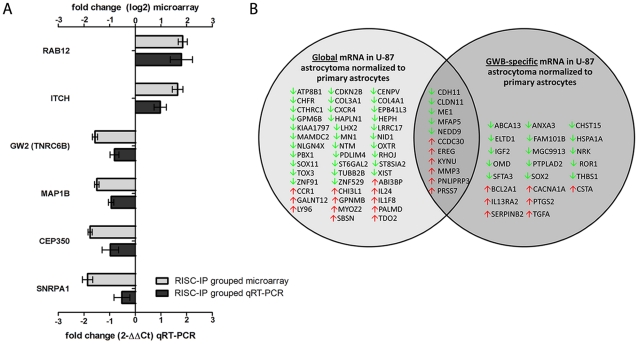
(A) MRNA microarray validation with qRT-PCR analysis in grouped RISC-IP U-87 astrocytoma and primary astrocytes samples. Grouped RISC-IP data were compared to the grouped global mRNA from U-87 astrocytoma and primary astrocytes samples. Eight mRNAs were selected from the grouped mRNA microarray dataset and examined by qRT-PCR. Fold change from the mRNA microarray are given by log2 values (left y-axis, light grey bars). Fold change from the qRT-PCR was determined using the 2-ΔΔCt method and all mRNA expression values were normalized to the beta-actin endogenous control (right y-axis, dark grey bars). Error bars represent the standard deviation of the mean (SD). Importantly, the fold change (y-axis) cannot be directly compared between assays due to differences in calculation methods, but the general trend of up-regulation and down-regulation can be compared. (B) MRNAs in RISC compared to the global cellular milieu in U-87 astrocytoma cells. MRNA expression in U-87 astrocytoma cells were normalized to primary astrocytes mRNA expression. All mRNAs had a fold change >2.5 and were significantly expressed (p<0.01). Green and red arrows indicate decreased and increased levels respectively.